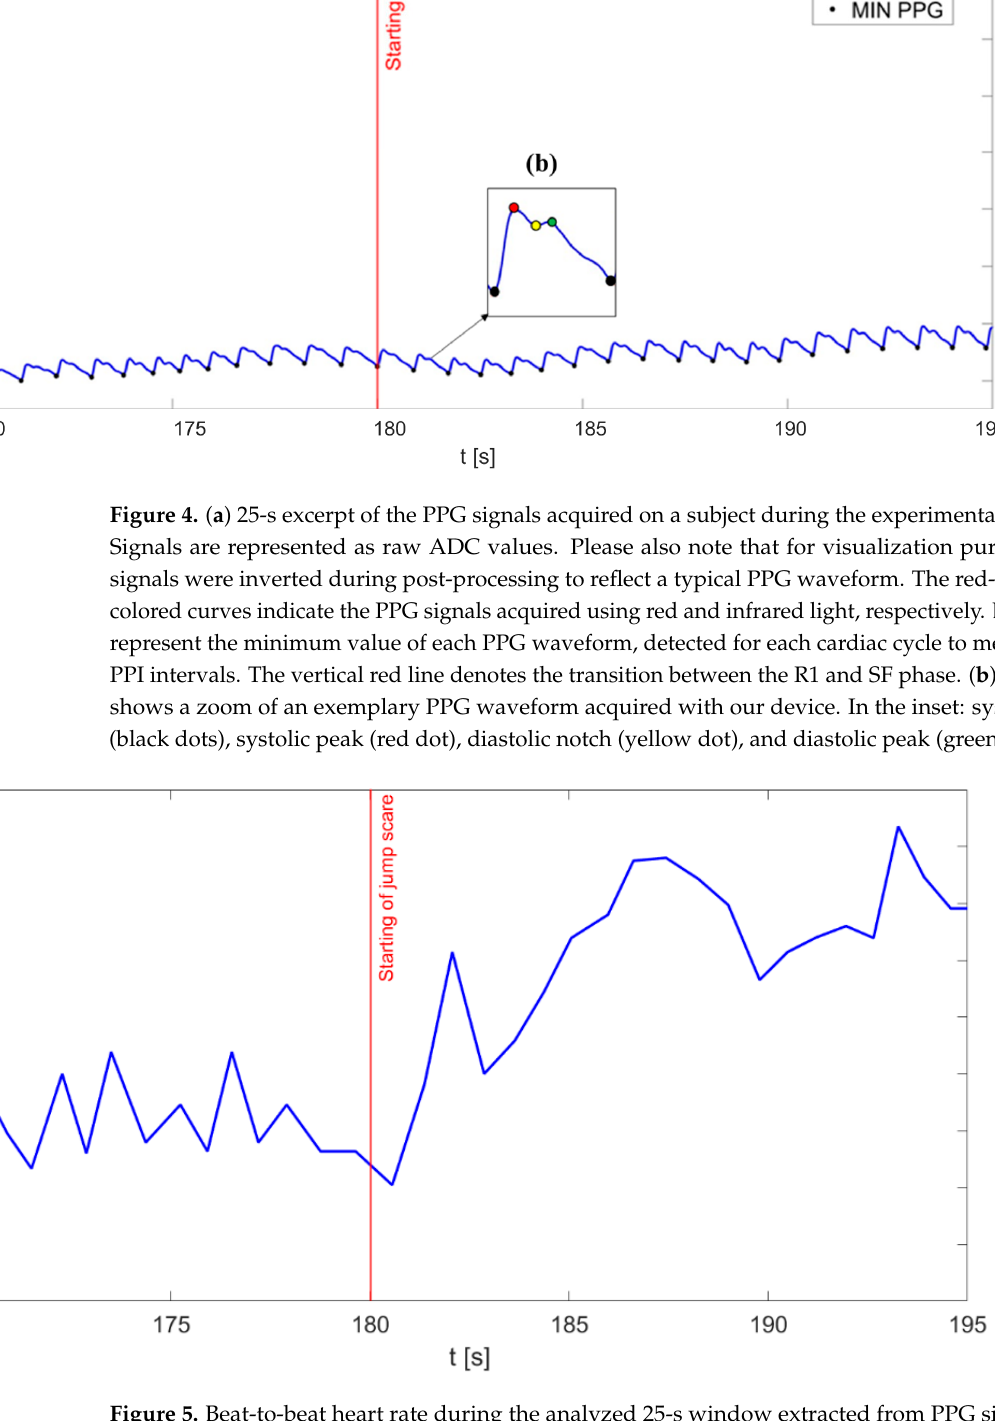
Figure 5. Beat-to-beat heart rate during the analyzed 25-s window extracted from PPG signal. The vertical red line marks the transition between the R1 and the SF phase.